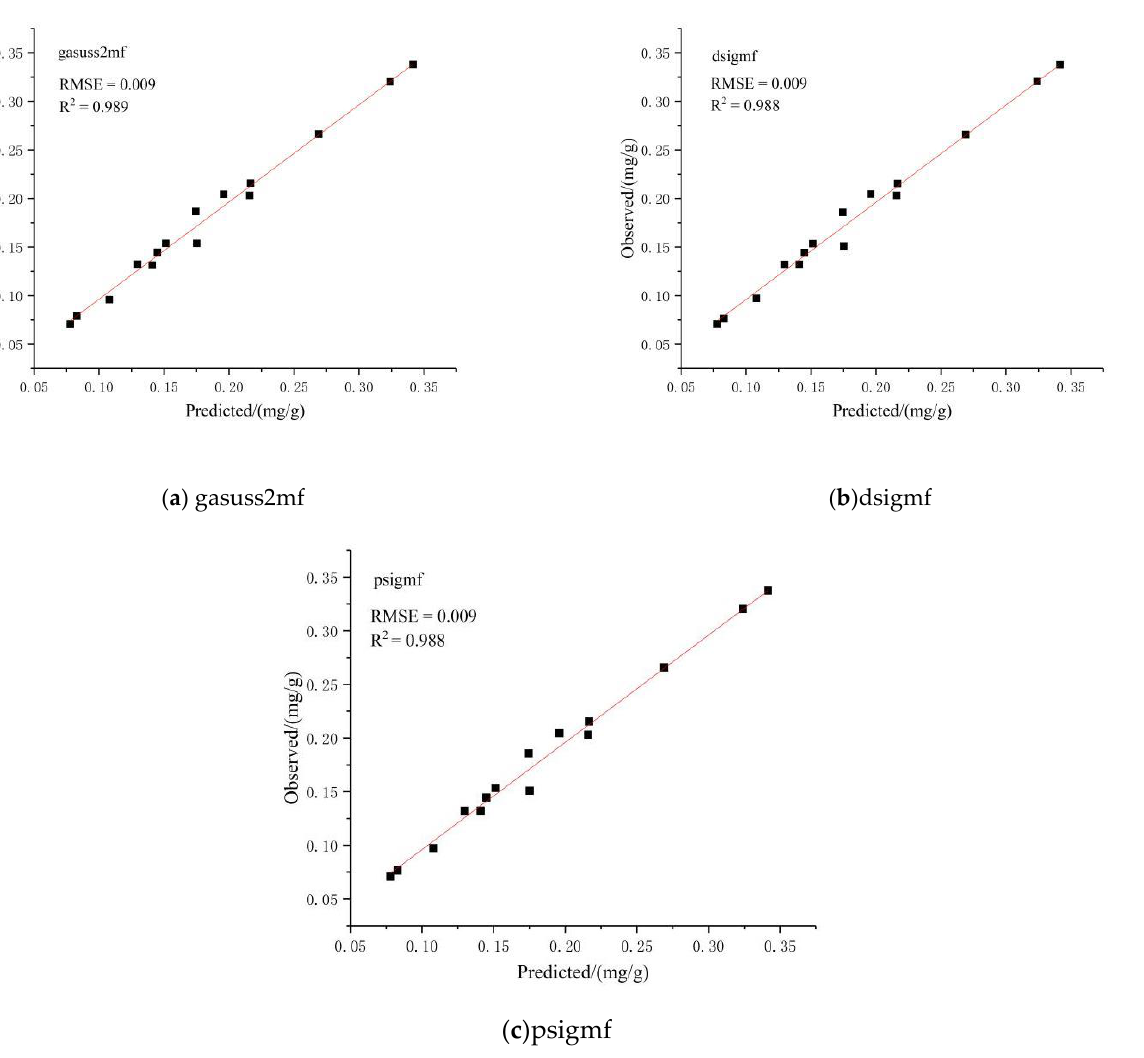
Figure 6. Scatter plots of the observed values versus the predicted values for chlorophyll content in the pericarp of fragrant pears by the ANFIS model with gasuss2mf, dsigmf and